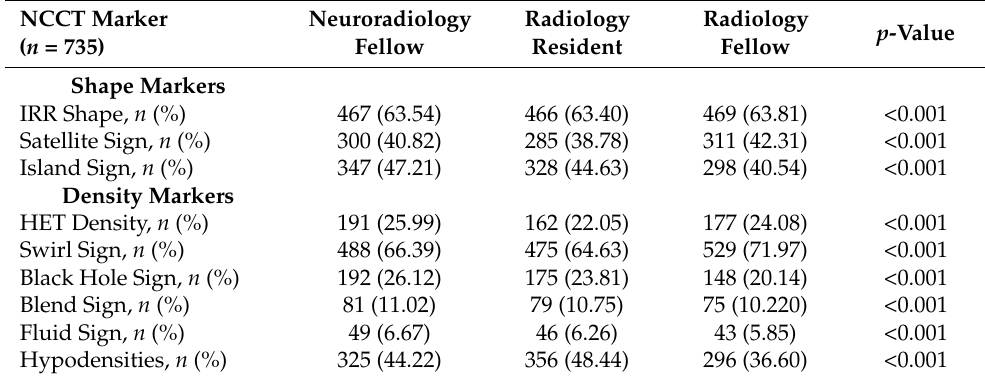
Table 2. Distribution of Noncontrast Computed Tomography Signs (NCCT Signs) in patients with acute intracerebral